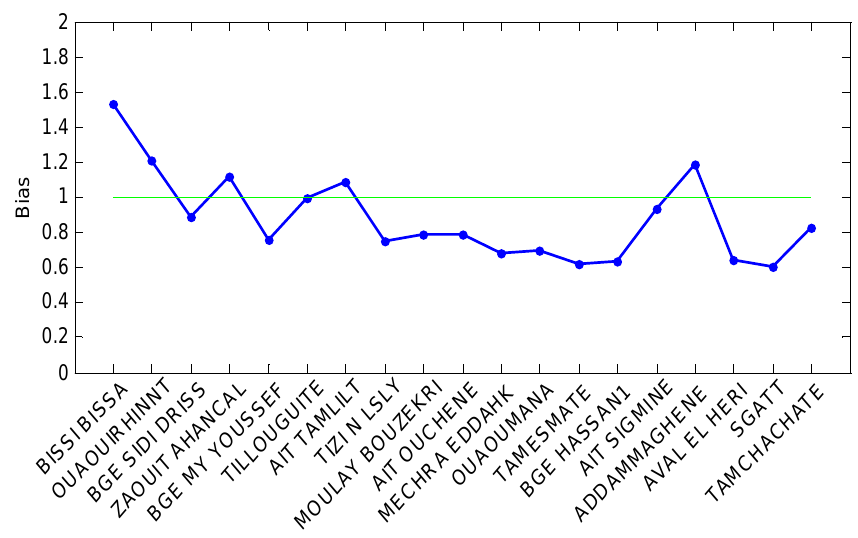
Figure 7. Bias sorted according to the monthly average rainfall.